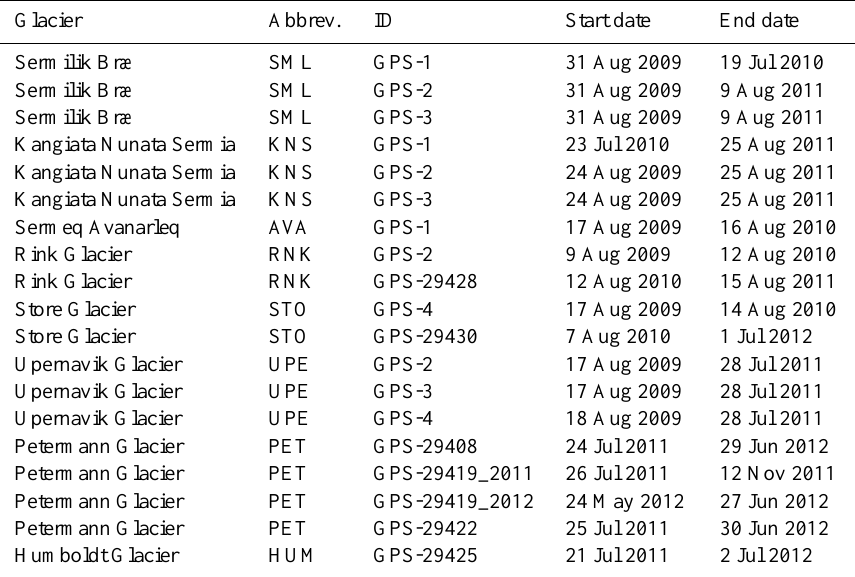
Table 1. Temporal coverage of the GPS data collected. Abbreviations and ID’s refer to the map in Fig. 1. Geographical positions are listed in Tables 2 to 4. Glacier